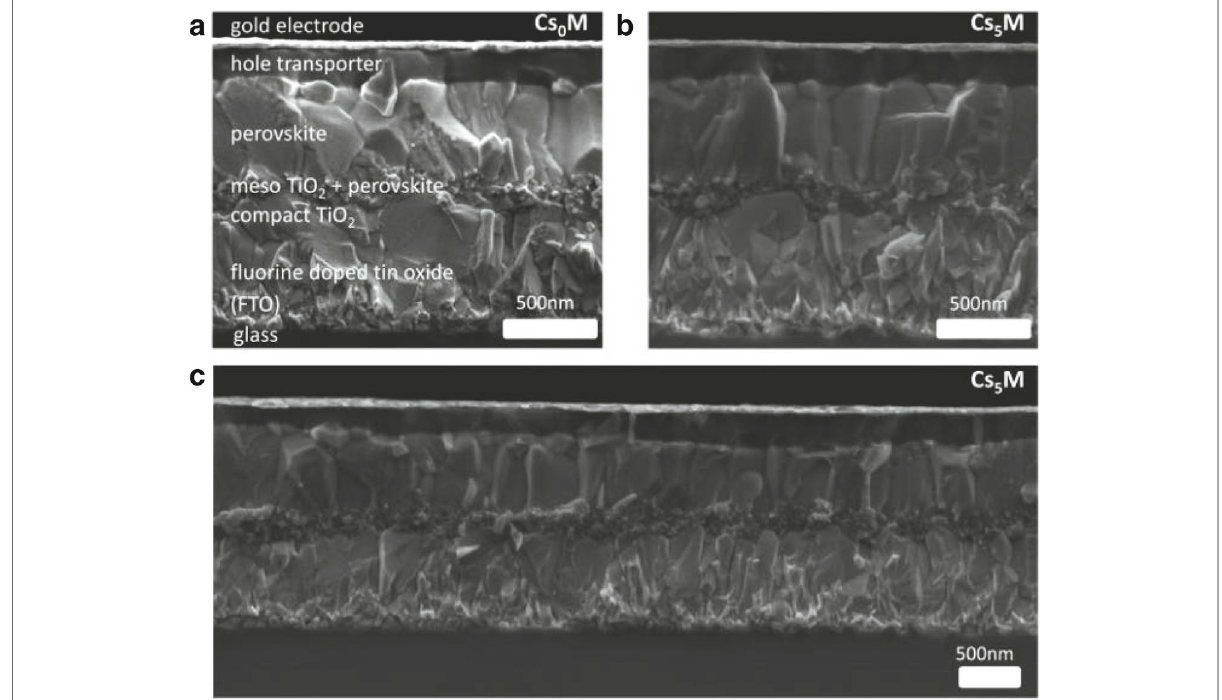
Fig. 4 Cross-sectional SEM images of a Cs 0 M, b Cs 5 M, and c low-magnification Cs5M devices